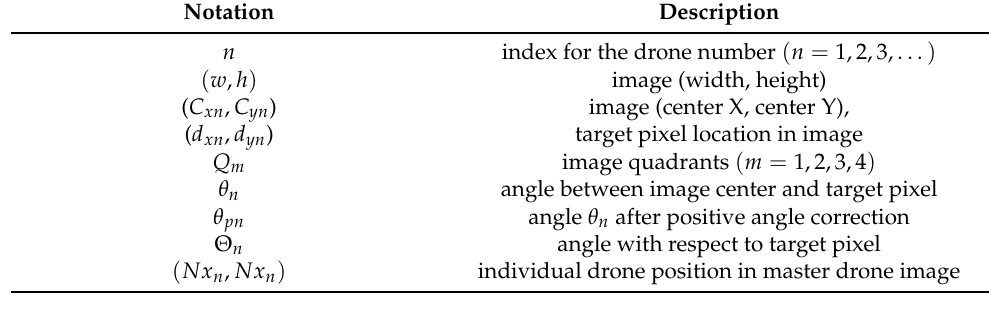
Table 2. List of notations.